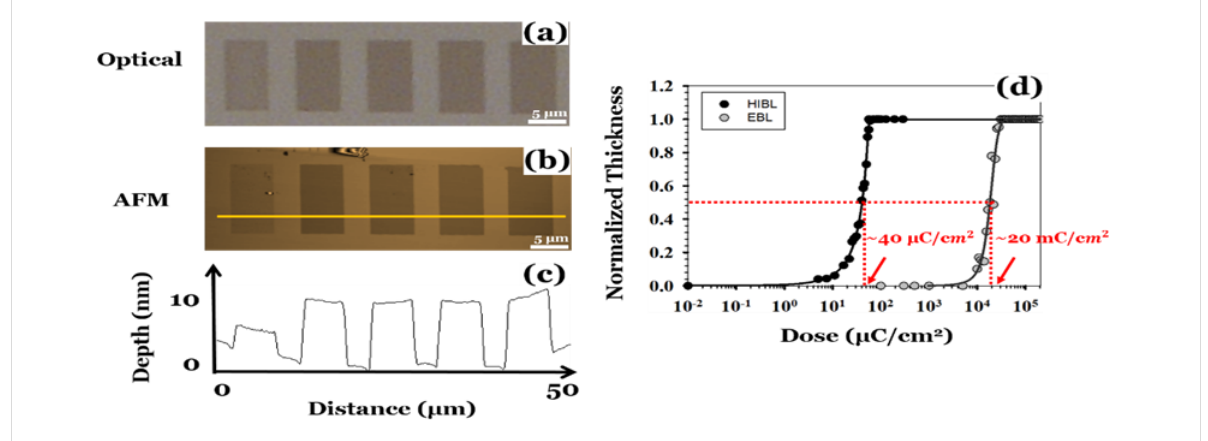
Figure 6: Results of SHIBL at 30 keV beam energy: (a) optical micrograph, (b) AFM image, (c) line profile (HM-01 fullerene resist thickness ca. 10 nm). He + doses left to right: 37.9, 56.5, 85.0, 128.0, 192.0 μ C·cm − 2 , (d) Comparison of the dose response curves for HM-01 in SHIBL and EBL. Sensitivities are 40 µC·cm − 2 and 20 mC·cm − 2 , respectively, revealing a 500-fold increased sensitivity in SHIBL [41].